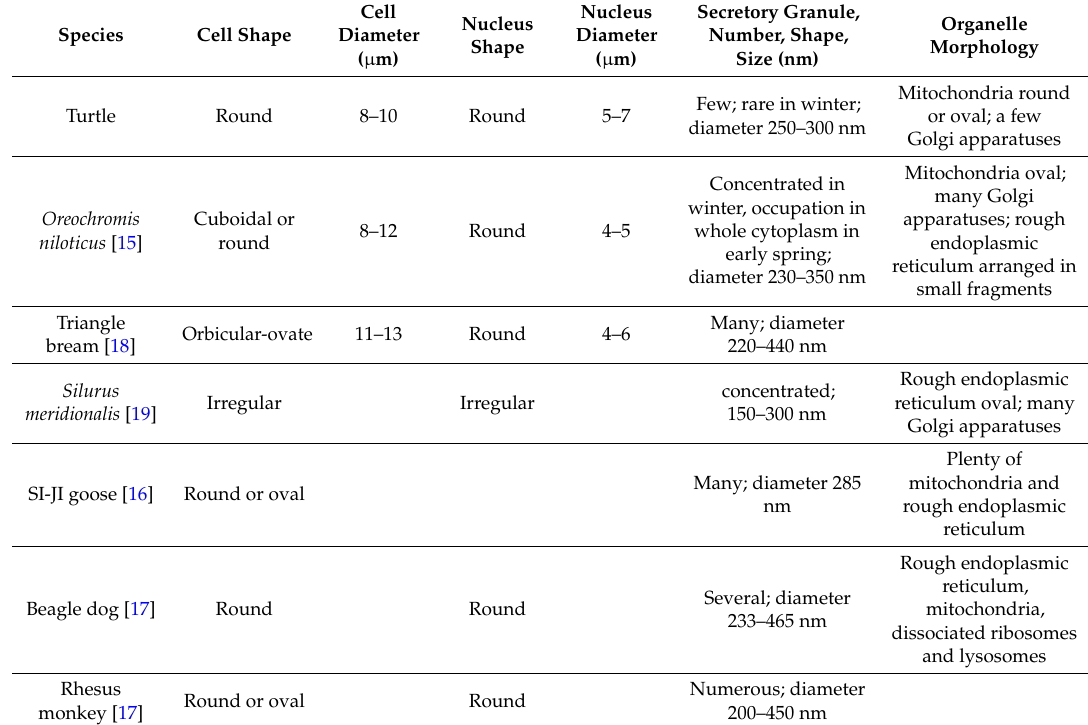
Table 1. Comparison of GH cell ultrastructure among different